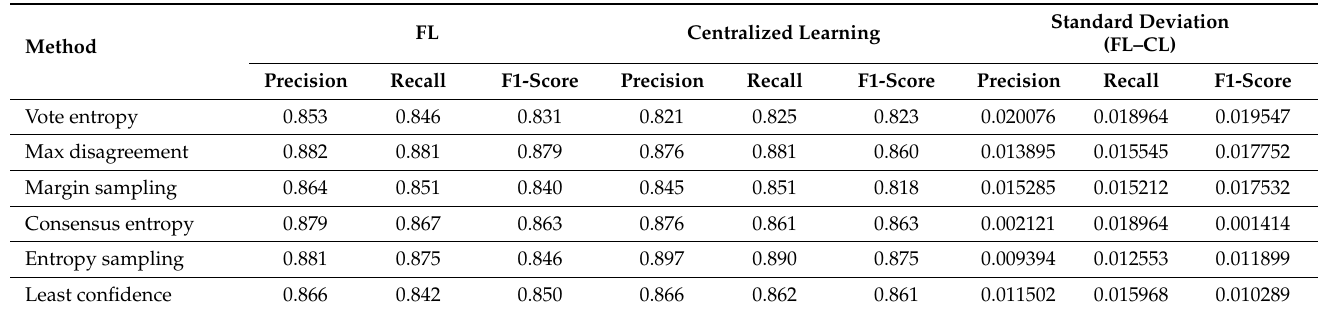
Table 6. Comparative assessments of the AL approach in FL (client nodes = 6) and centralized learning contexts with respect to the weighted accuracy, recall, and F1-score under various sampling and disagreement techniques for human physical activities in the disaster situation dataset